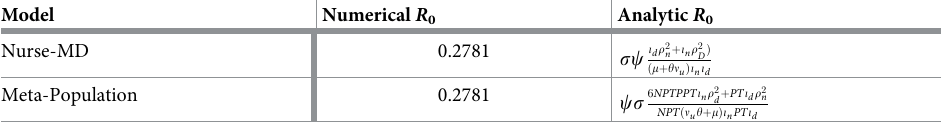
Table 2. Values of R 0 for two ICU